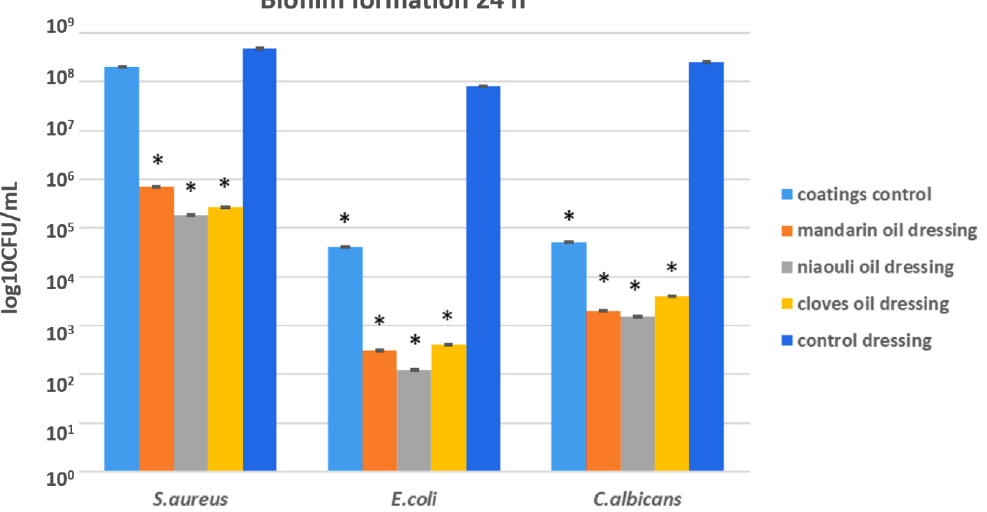
Figure 12. Biofilm formation in the presence of tested nanocoatings coatings control = microbial cells attached to the coatings control-dressing modified with silver NPs. Mandarin oil dressing = microbial cells attached to the mandarin dressing modified with silver NPs and mandarin EO. Niaouli oil dressing = microbial cells attached to the niaouli dressing modified with silver NPs and niaouli EO. Clove dressing = microbial cells attached to the cloves dressing modified with silver NPs and clove EO. Control dressing = microbial cells attached to the commercial wound dressing (containing silver NPs and EO free). * p < 0.05 (control coatings vs. NPs and EO coated samples for each strain).